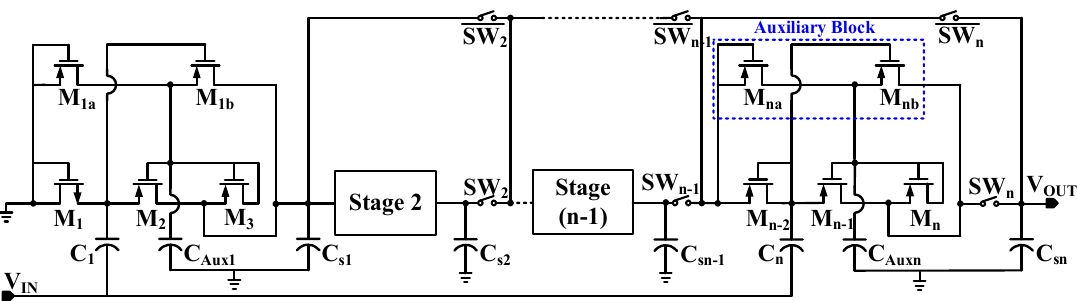
Figure 4. Circuit diagram of the proposed reconfigurable RF–DC converter using internal threshold voltage cancellation (IVC) with auxiliary block.